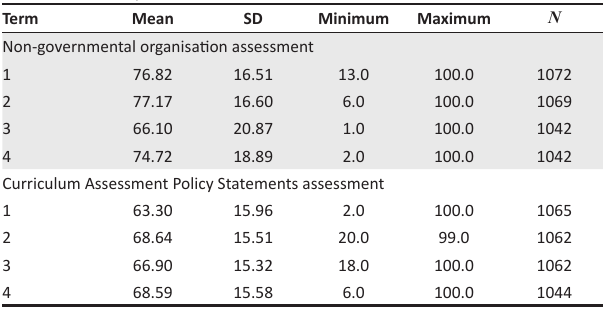
TABLE 2: Learner performance on assessments. Term